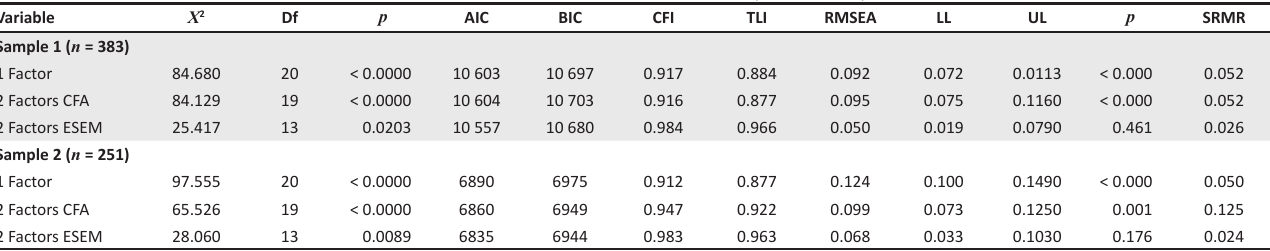
TABLE 1 : Fit indices for unidimensional, CFA bidimensional, and ESEM bidimensioanl models for sample 1 and sample 2. Variable